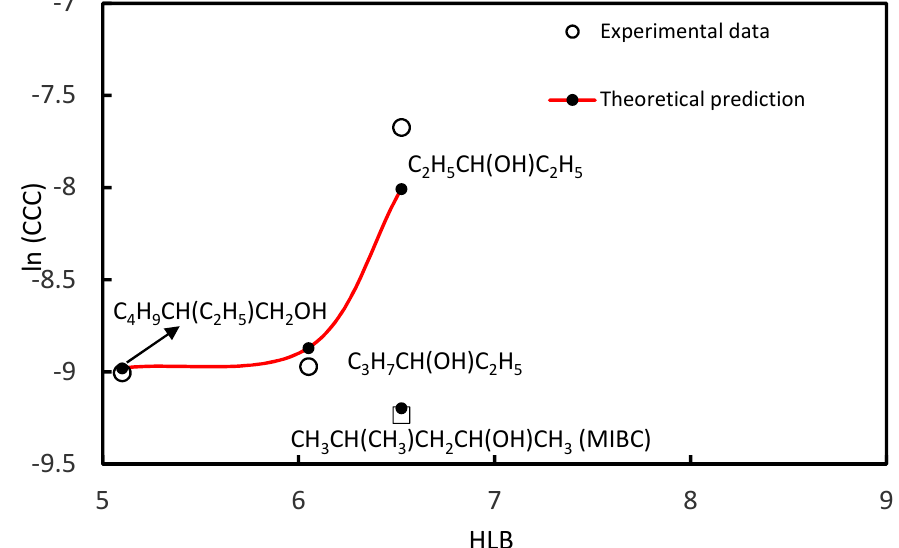
Figure 4. Experimental [37] and theoretical (see Equation (2)) values of ln(CCC) versus HLB values of the tertiary alcohols C 2 H 5 CH(OH)C 2 H 5 , C 3 H 7 CH(OH)C 2 H 5 [38], C 4 H 9 CH(C 2 H 5 )CH 2 OH [56] and MIBC (produced in this study).